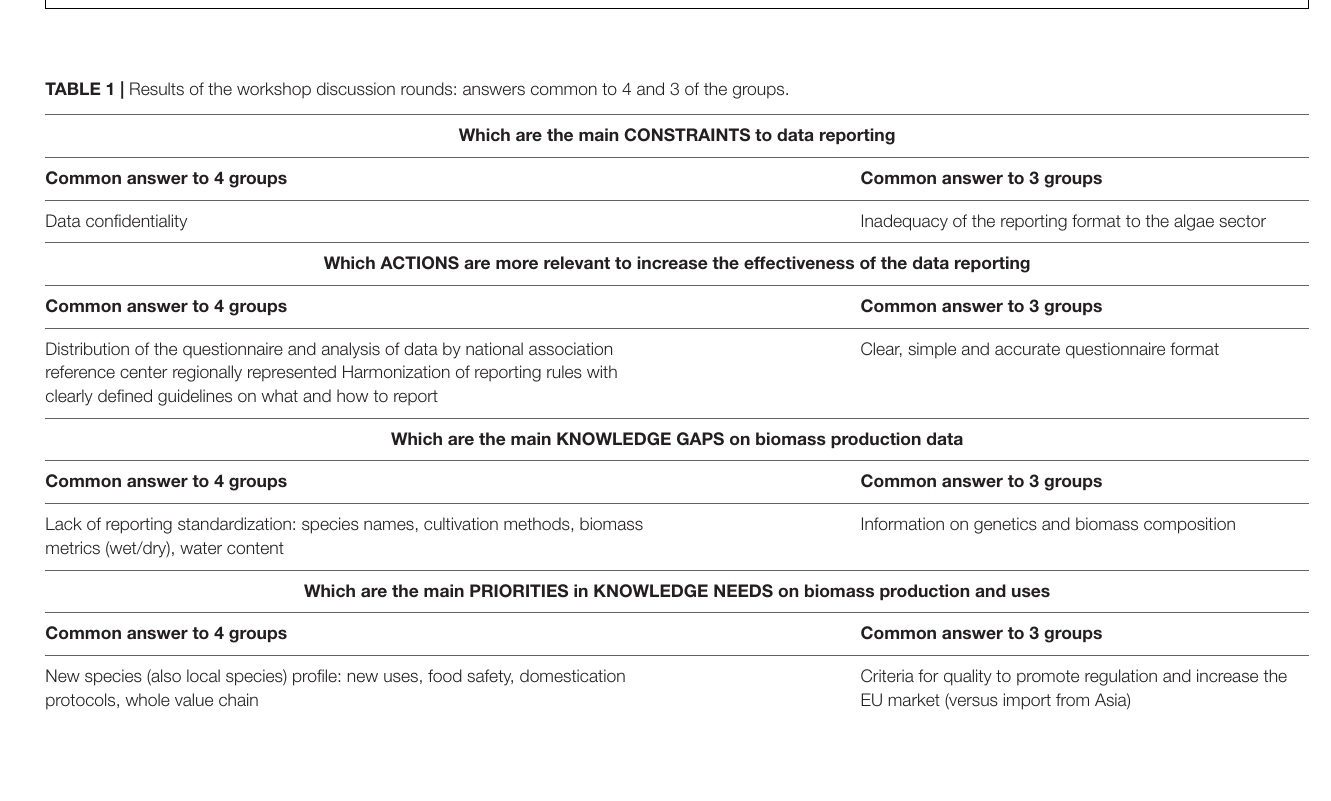
FIGURE 1 | Workshop organization and description.